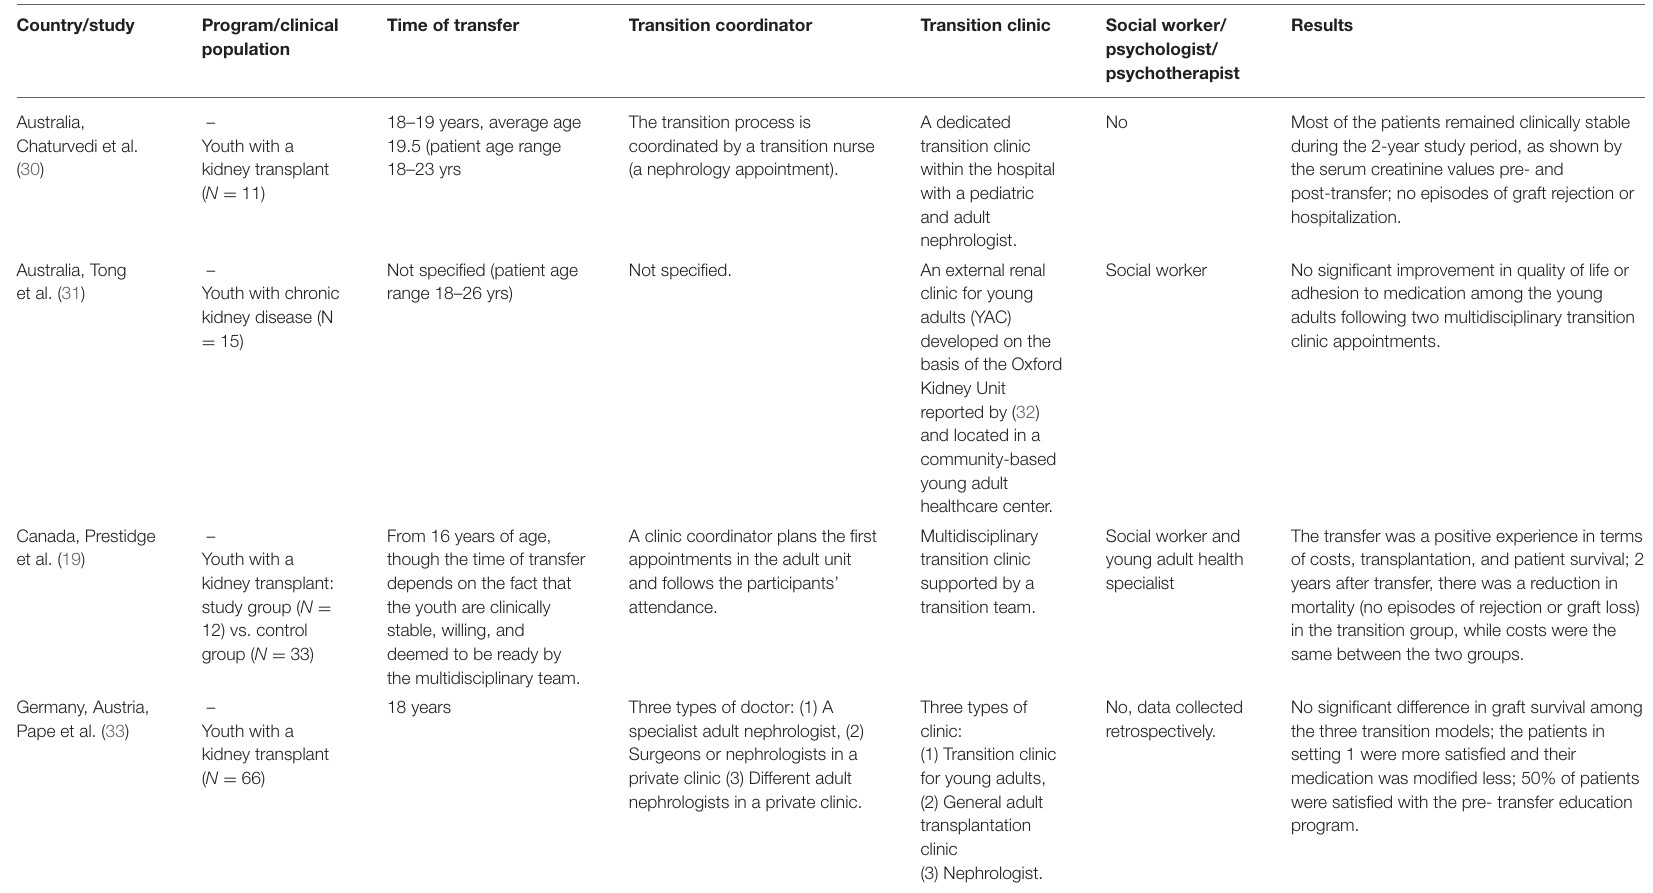
TABLE 2 | Characteristics of healthcare transition for adults and youth with chronic kidney